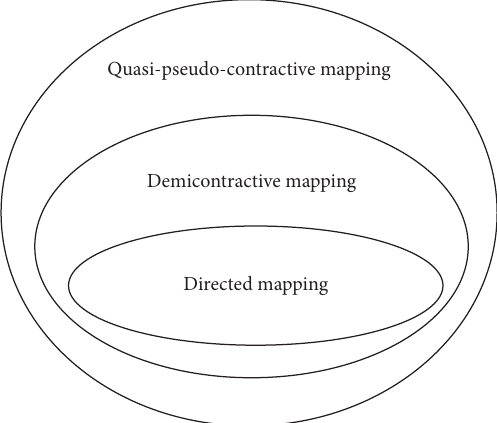
Figure 5: The relations of some nonlinear operators.